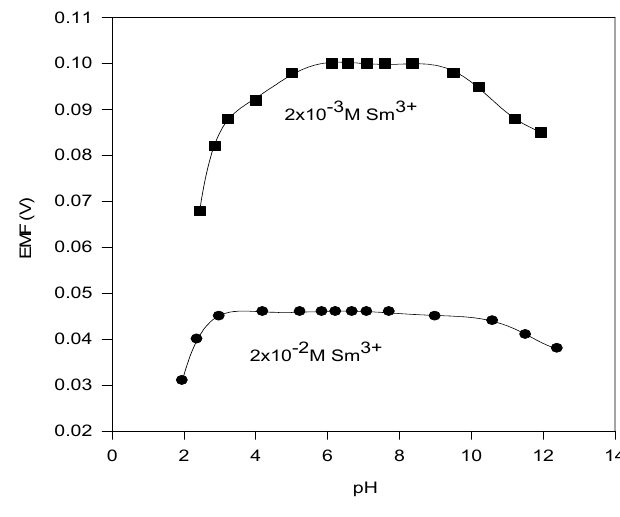
Figure 3. Effect of pH on the response of Sm (III) selective electrode based on